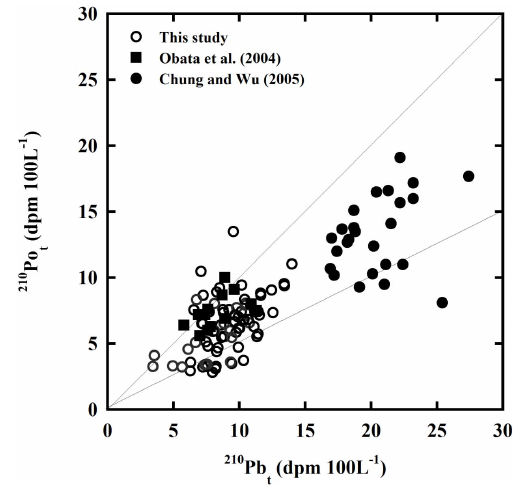
210 Po Fig. 4 Figure 4. Correlation of 210 Pb t and t for the data at station PA-11 of Obata et al. (2004) (solid square), at station C of Chung and Wu (2005) (solid circle), and at station SEATS of this study (open circle). Slopes of 0.5 and 1 are shown as solid